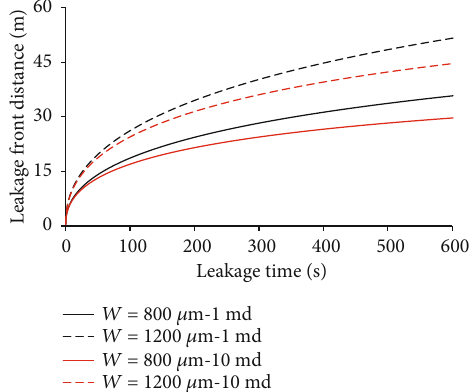
Figure 23: Leakage rate under di ff erent formation permeability and initial width of natural fracture.